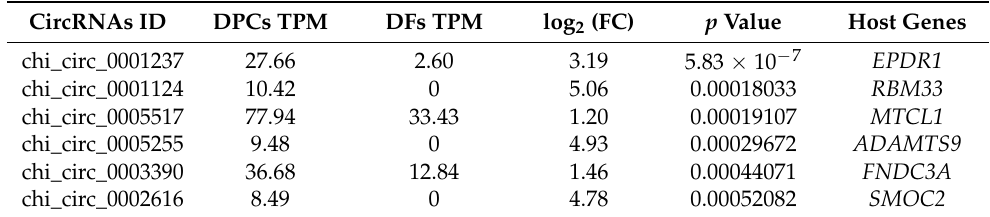
Figure 3. Global expression pattern and differential expression analysis of circRNAs. ( a ) Box-plot showing the distribution pattern of circRNAs based on normalized abundances; ( b , c ) Principal component analysis (PCA) and cluster dendrogram analysis of samples based on TPM values of each transcript; ( d , e ) Volcano plot and heatmap showing relative expression levels and statistical significances of circRNAs between goat DPCs and DFs. p < 0.05 was thought of as statistically significant. Table 1. Top 20 differentially expressed circRNAs between goat DPCs and DFs ranked by statistical significance.